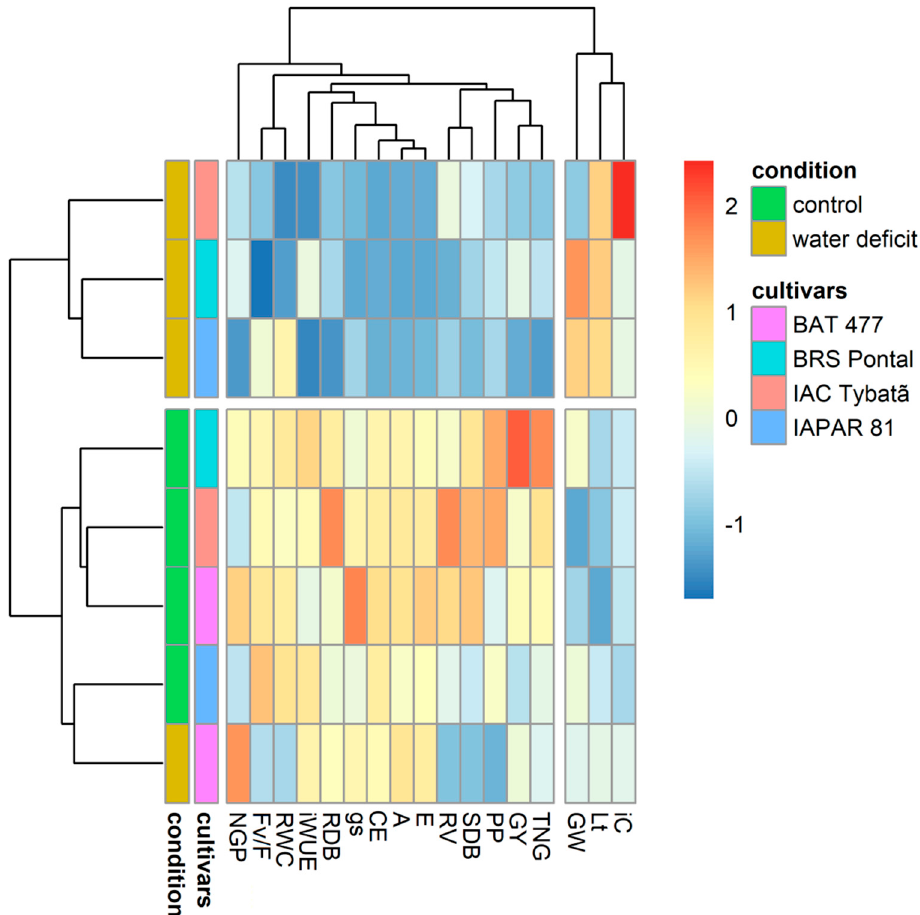
Figure 4. Heatmap of the morphoagronomic and physiological traits of common bean cultivars evaluated under water-stressed and unstressed conditions. Shoot dry biomass (SDB); Root dry biomass (RDB); root volume (RV); number of pods per plant (PP); number of grains per plant (NGP); total number of grains per plant (TNG); 100-grain weight (GW); grain yield per plant (GY); net photosynthesis rate ( A ); transpiration ( E ); stomatal conductance ( g s ); intracellular concentration of CO 2 ( iC ); intrinsic water use e ffi ciency ( i WUE); maximum photochemical e ffi ciency of photosystem II ( F v / F m ); relative leaf water content (RWC); carboxylation e ffi ciency (CE); and leaf temperature